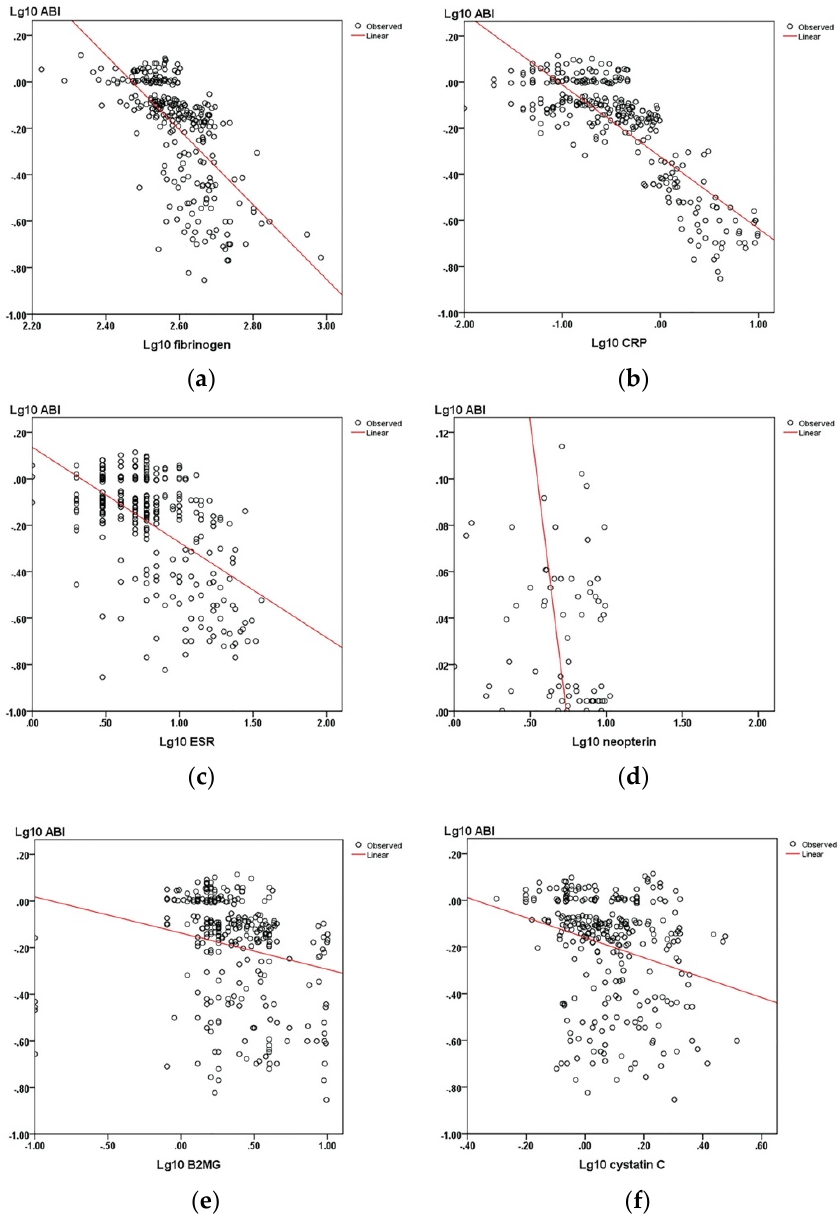
Figure 1. The correlations between the ABI and biomarkers: ( a ) Fibrinogen; ( b ) CRP; ( c ) ESR; ( d ) neopterin; ( e ) beta-2-microglobulin; and ( f ) cystatin C. Table 3. Correlations between CD, ABI, the number of arteries with significant stenosis (>50% and >70%) and biomarkers.